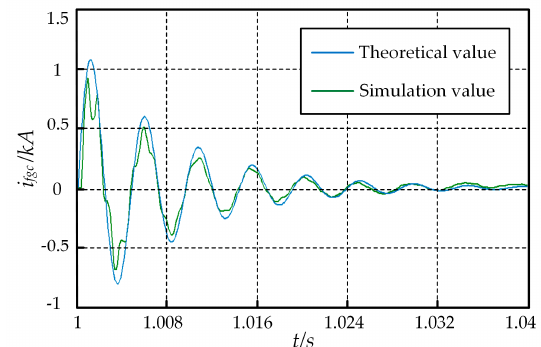
Figure 8. Theoretical value and simulation value of i fgc .